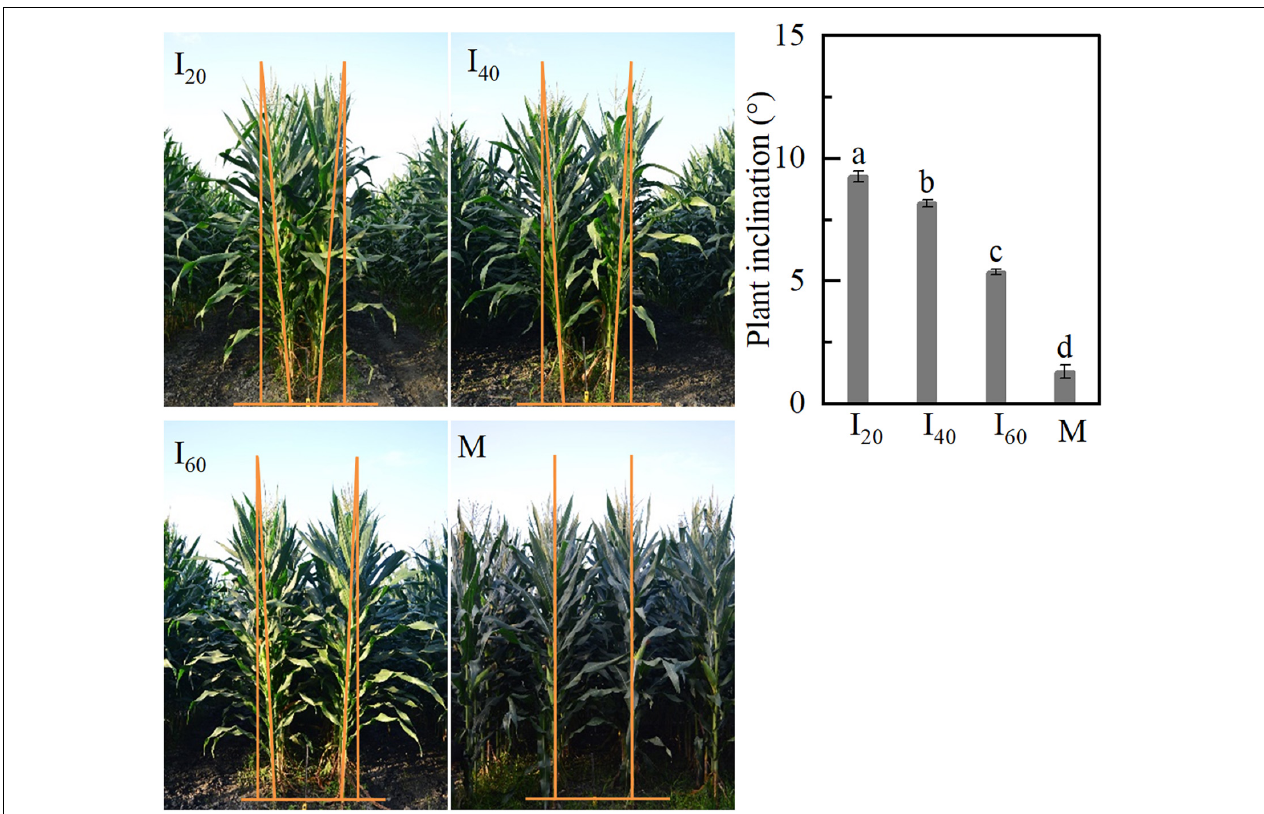
FIGURE 2 | Plant inclination in Study 1 (2020). I 20 , I 40 , and I 60 represent the intercropping maize planted in narrow–wide row spacing patterns, narrow and wide row spacing of 20 + 200, 40 + 180, and 60 + 160 cm, respectively. M: monoculture maize with a row spacing of 70 cm. Data with different letters are significantly different ( p <